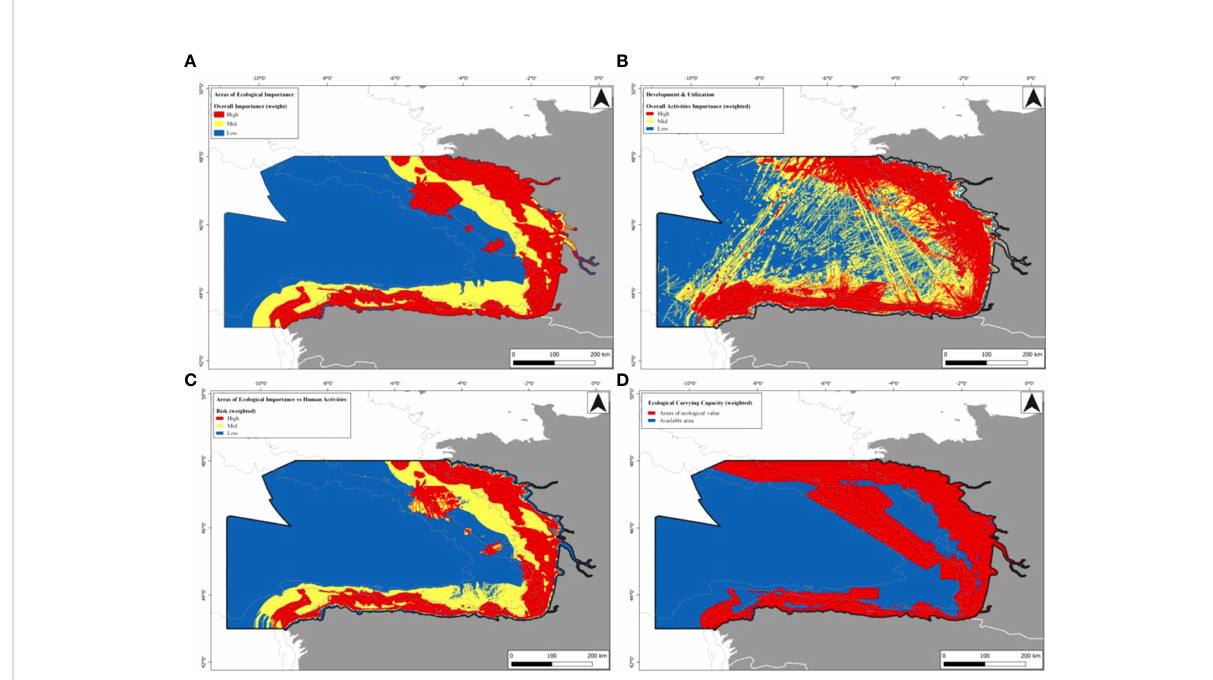
FIGURE 8 Results of the weighting approach: (A) Areas of Ecological Importance, (B) Aggregated assessment of the spatial distribution of important areas for human activities; (C) Ecological risk assessment; and (D) Marine Resource-Environment Carrying